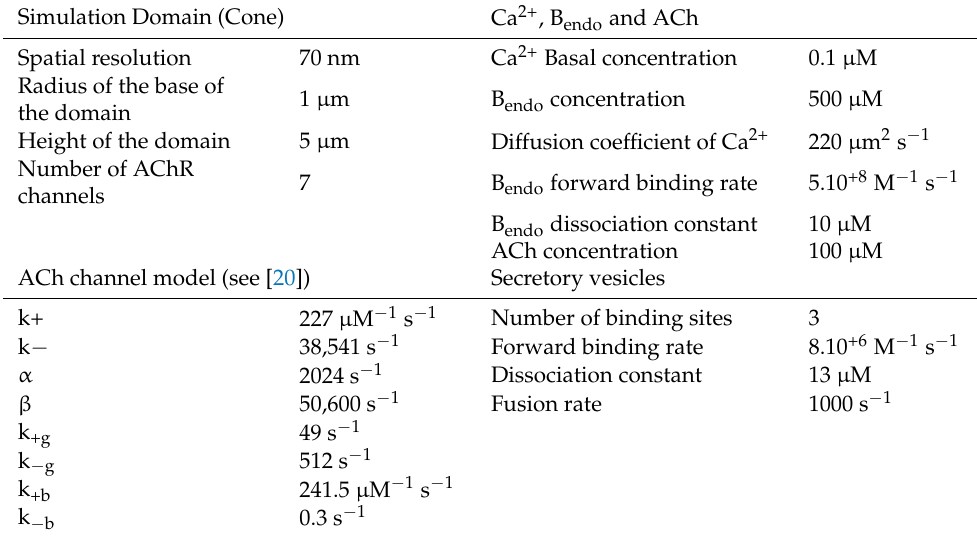
Table 2. Parameters used in the simulation of buffered calcium diffusion in a conical